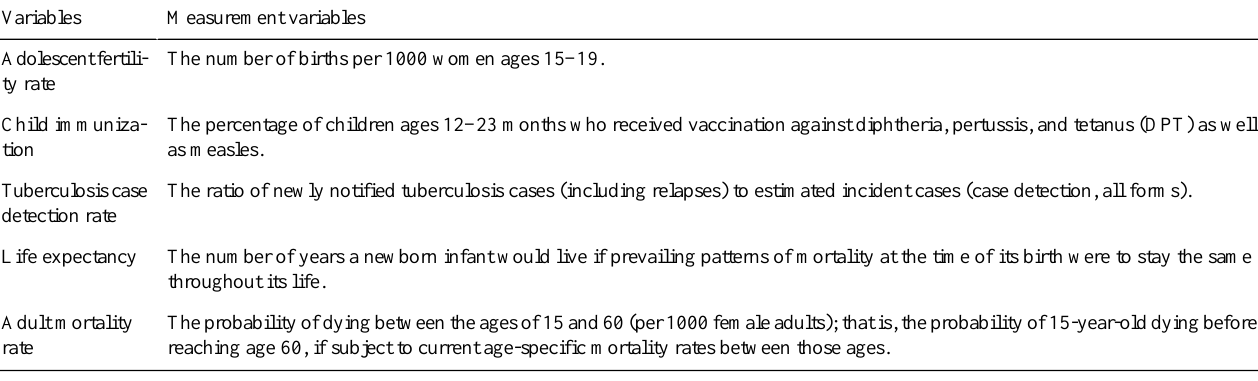
Table 2. Measurement items for public health indicators. Measurement variablesVariables